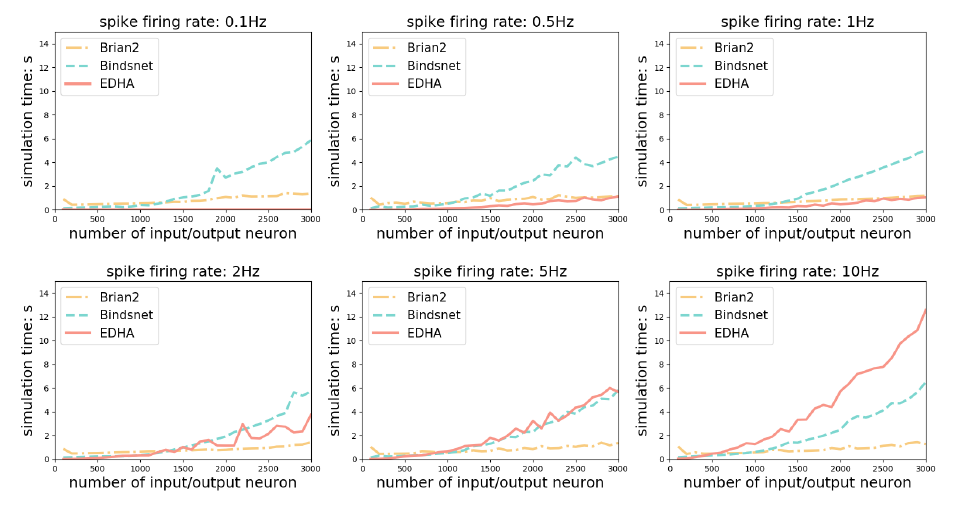
Figure 11. Benchmark simulation with fixed weight.